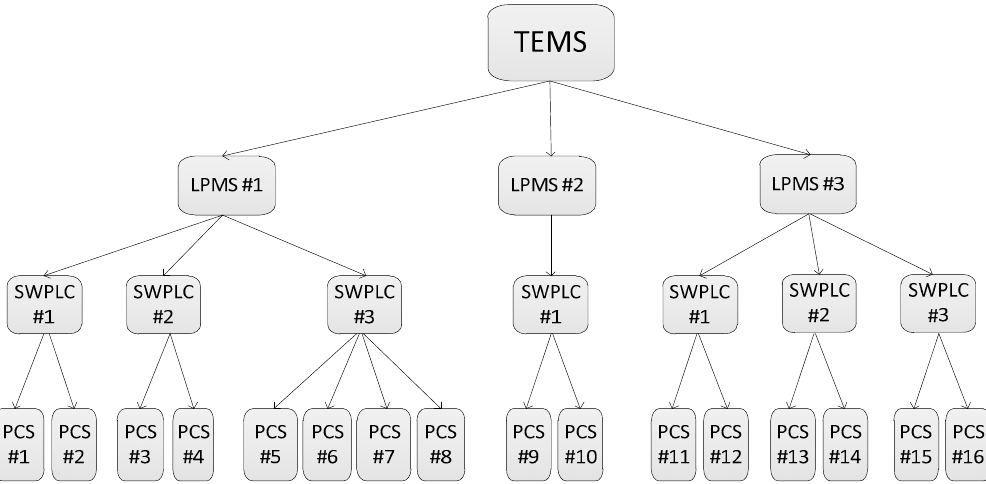
Figure 12. ESS demonstration structure.